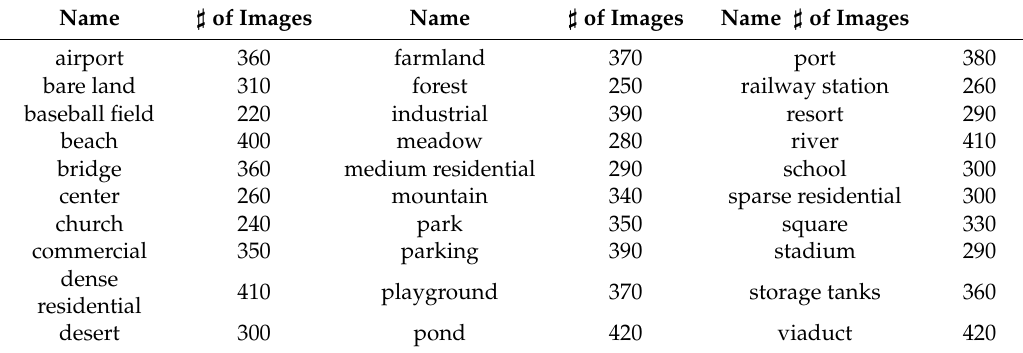
Table 1. The number of scene images per class in the Aerial Image Dataset